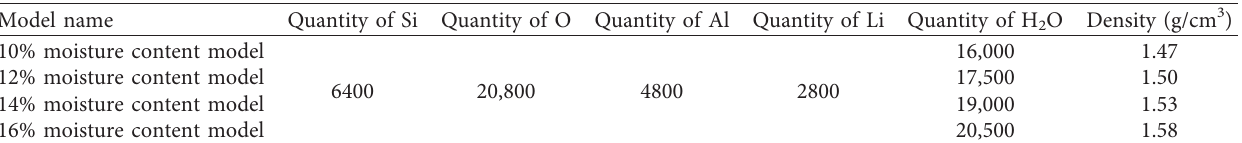
Table 1: Atomic number and density of molecular